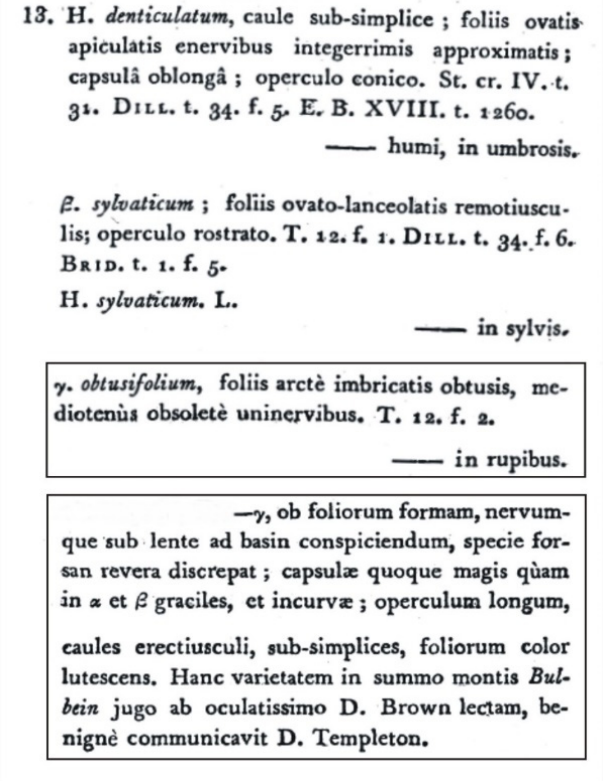
Figure 1. Diagnosis of Hypnum denticulatum var. obtusifolium [1]. Fragments concerning the described taxon are marked in the frame.